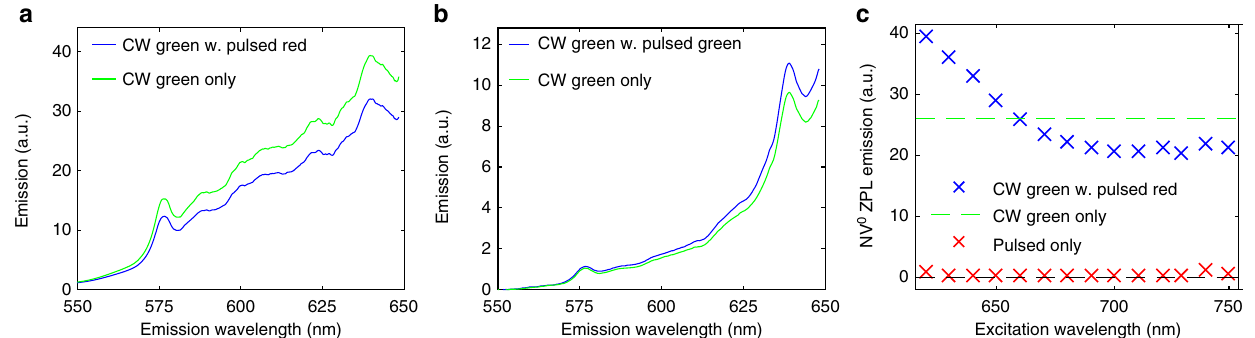
Figure 2 | Emission reduction of both zero-phonon lines. ( a ) Spectral emission of the NV centre ensemble due to 532nm continuous wave (CW) laser excitation alone (green), and due to an added pulsed 700nm laser excitation (blue). The emission with both lasers on is reduced compared with only green CW excitation. This is consistent with a preferential emission at 700nm due to stimulated emission. ( b ) When the pulsed laser wavelength is changed to also be at 532nm, the emission is increased by the pulsed laser. All the spectra were smoothed with a 4nm window. ( c ) Two regimes exist: the NV 0 emission is decreased by the addition of pulsed laser wavelengths above 680nm, where stimulated emission dominates, and increased for pulsed wavelengths below 640nm, where ionization from NV (cid:2) to NV 0 is known to be the dominant process. In the measured range of wavelengths the pulsed laser alone does not create any NV 0 signal, that is, there is no direct excitation. The pulsed power was kept constant at 2.9mW for all excitation